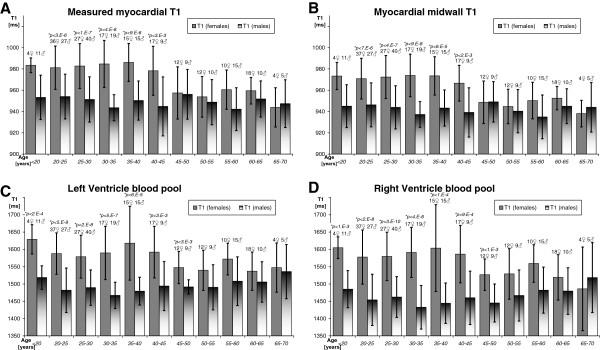
Age- and gender-dependence of myocardial and blood T1. A) Measured myocardial T1 within manually drawn myocardial contours demonstrated a small elevation of T1 in young females. B) Myocardial midwall T1 (see partial volume section), indicated a similar persistent gender difference, albeit at a slightly lower T1 likely due to reduction of blood partial volume. C) Left Ventricle blood T1. D) Right Ventricle blood T1. Note: Unpaired student T-test p-values are marked above each bar for age-groups when Bonferroni-corrected significance threshold is achieved for gender difference.